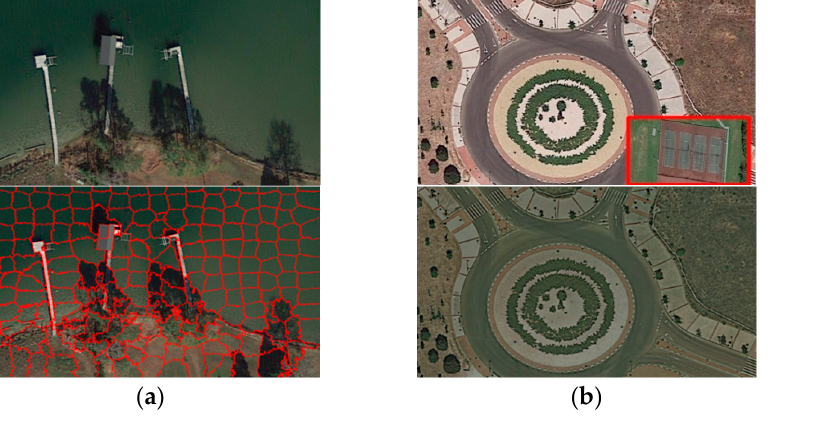
Figure 1. Three applications of superpixels in remote sensing images. ( a ) Remote sensing image segmentation; ( b ) Color transfer of remote sensing images. The image in the red box is the target image; ( c ) Reconstruction of average color on Superpixel-based is used for remote sensing tasks, such as supervised land — sea area change detection.